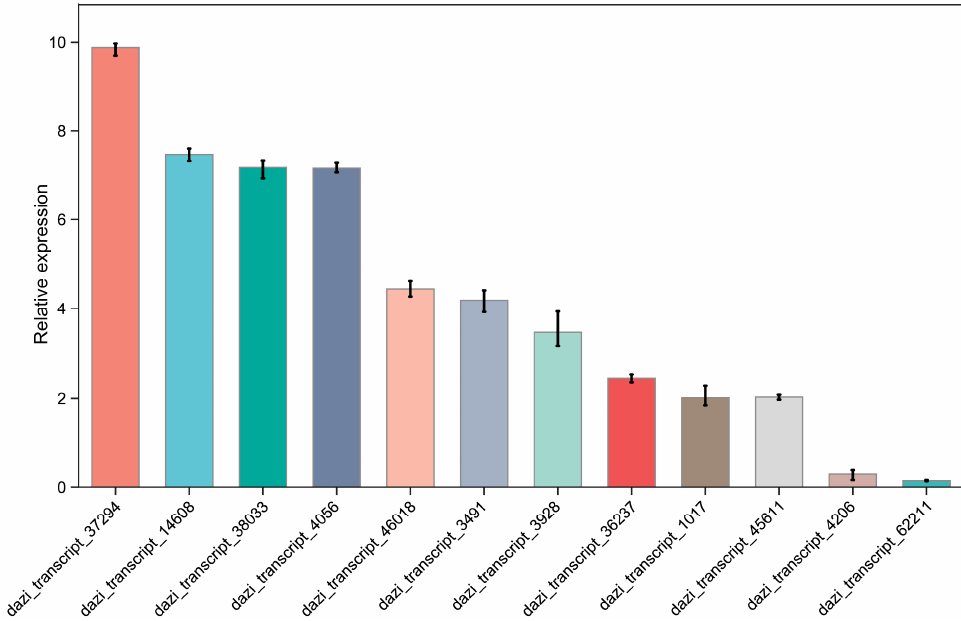
Figure 4. Expression profiles of key genes involved in carbohydrate metabolism and amino acid metabolism in A. arguta cv. Qinziyu.